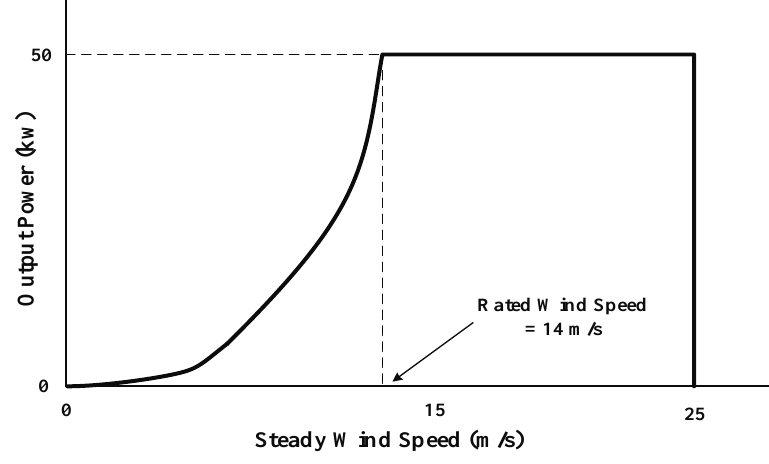
Fig. 3 . Typical wind turbine power output with wind